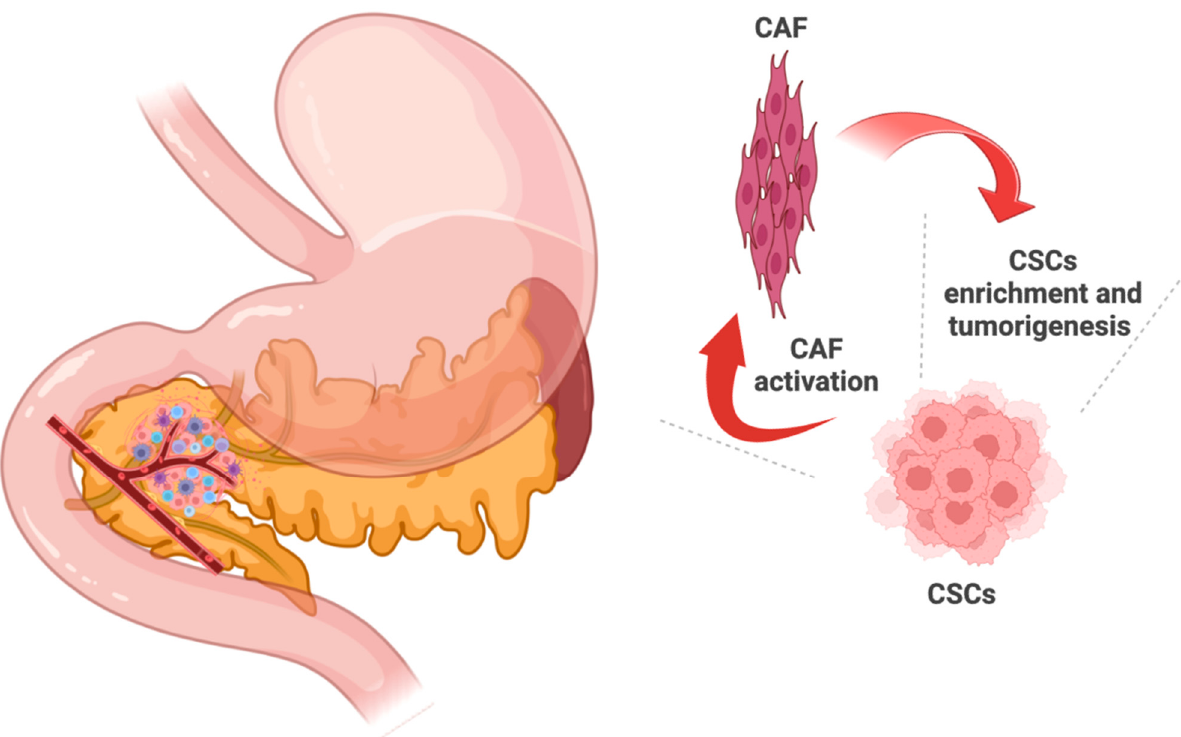
Figure 1. The tumor microenvironment is comprised of a diverse range of immune cells, the extracellular matrix, blood vessels, and cancer-associated fibroblasts (CAFs), and these factors are involved in the aggressiveness of pancreatic cancer cells. CAF: cancer associated fibroblasts. CSCs: cancer stem cells.